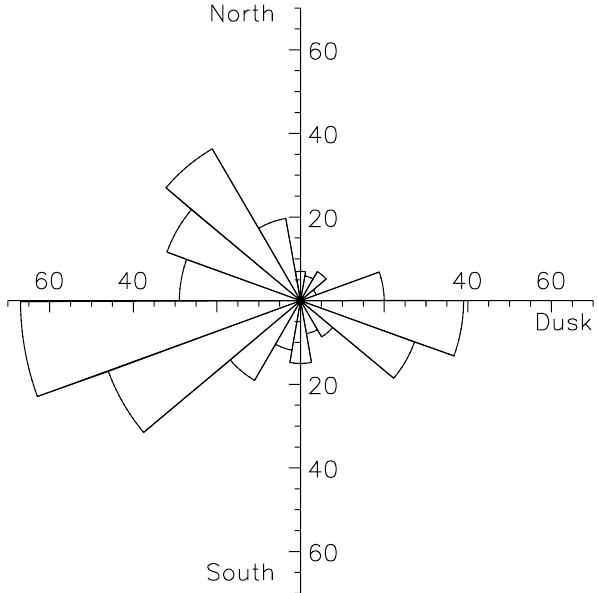
Fig. 1. The IMF clock angle distribution of the FTEs in the Fear et al. (2005) data set. The length of each bar indicates the number of events in each IMF direction. (Reproduced from Fear et al.,